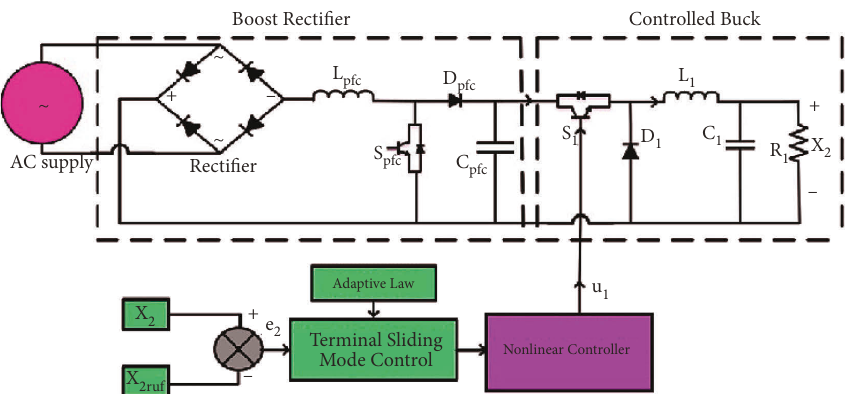
Figure 8: Integrated charging unit for PHEV.